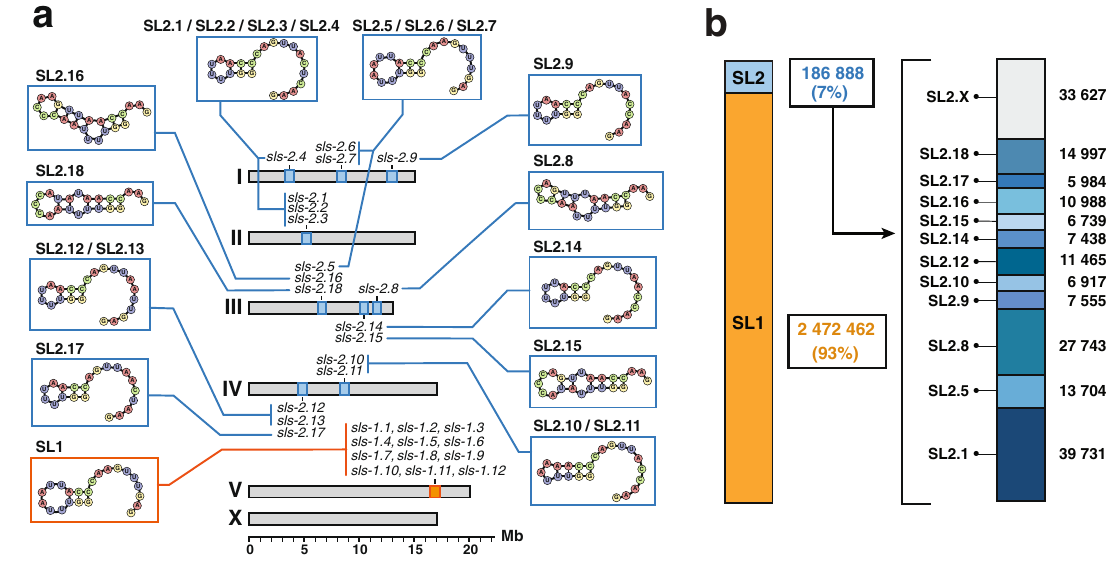
Fig. 2 | Spliced leaders usage frequency. a Genomic location of all C. elegans sls genes and structure of their 5 ’ hairpin strand. b Quanti fi cation of reads with high- quality Spliced Leader sequence reveals the usage frequency of each of the sls